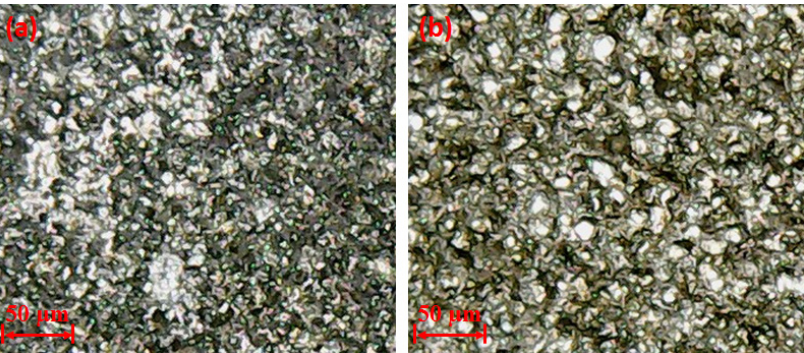
Figure 15. Micrographs representing electrode wear rate at 8A: ( a ) surface of copper tool subjected to less wear in graphene-mixed dielectric; ( b ) surface of aluminium electrode exposed to high wear in kerosene dielectric.